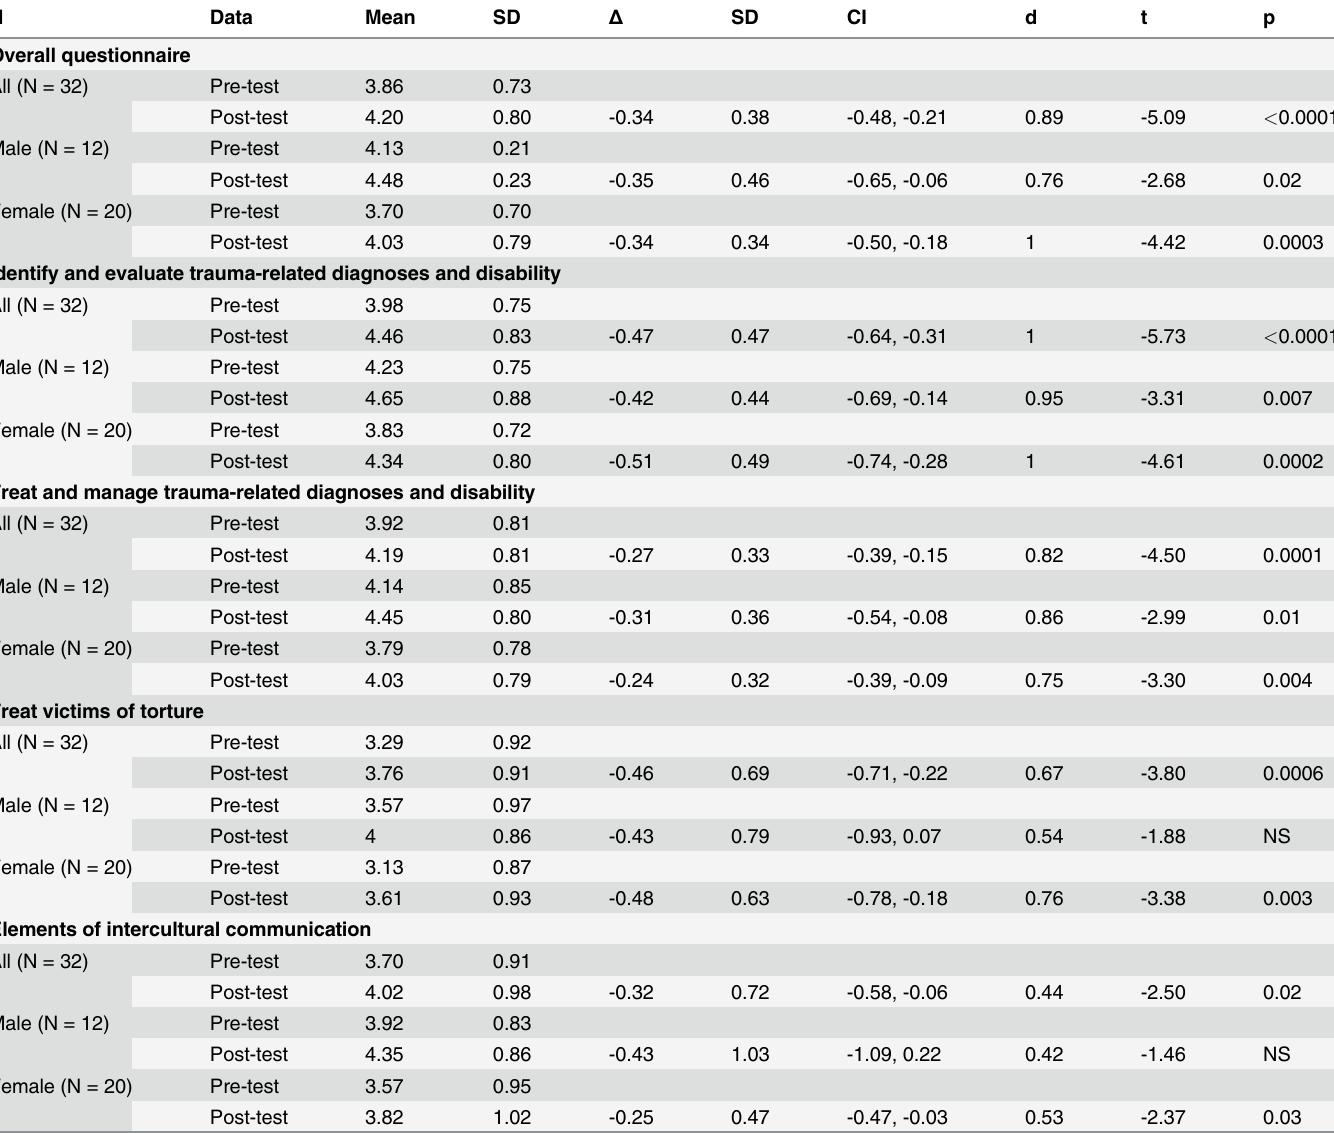
Table 2. Changes in mean con fi dence scores between pre- and post-test, by cluster and